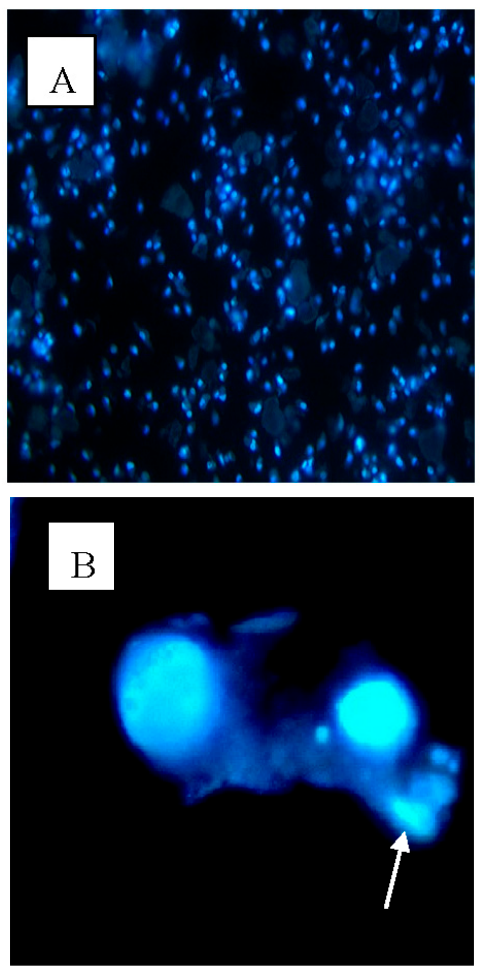
Figure 4. Fluorescent images of MCF-7 cells stained by Hoechst 33,342. ( A ) Control cells (×200); ( B ) treated with 25 µg/mL PVLH-EAE for 48 h (×400) (arrow show bleb formation).